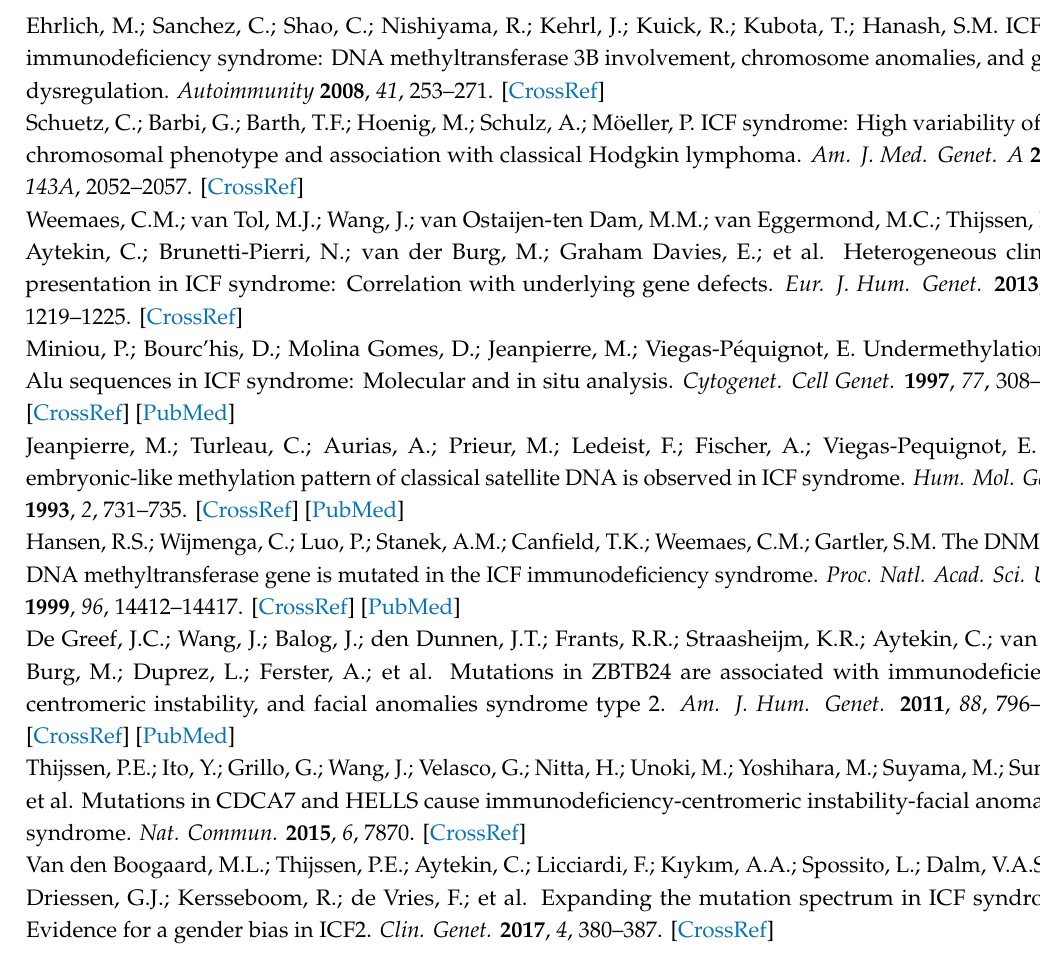
Table S1: Genotype, phenotype, immunological findings, treatment and outcome of all published ICF2 patients; File 1: immunological follow-up of all three here presented